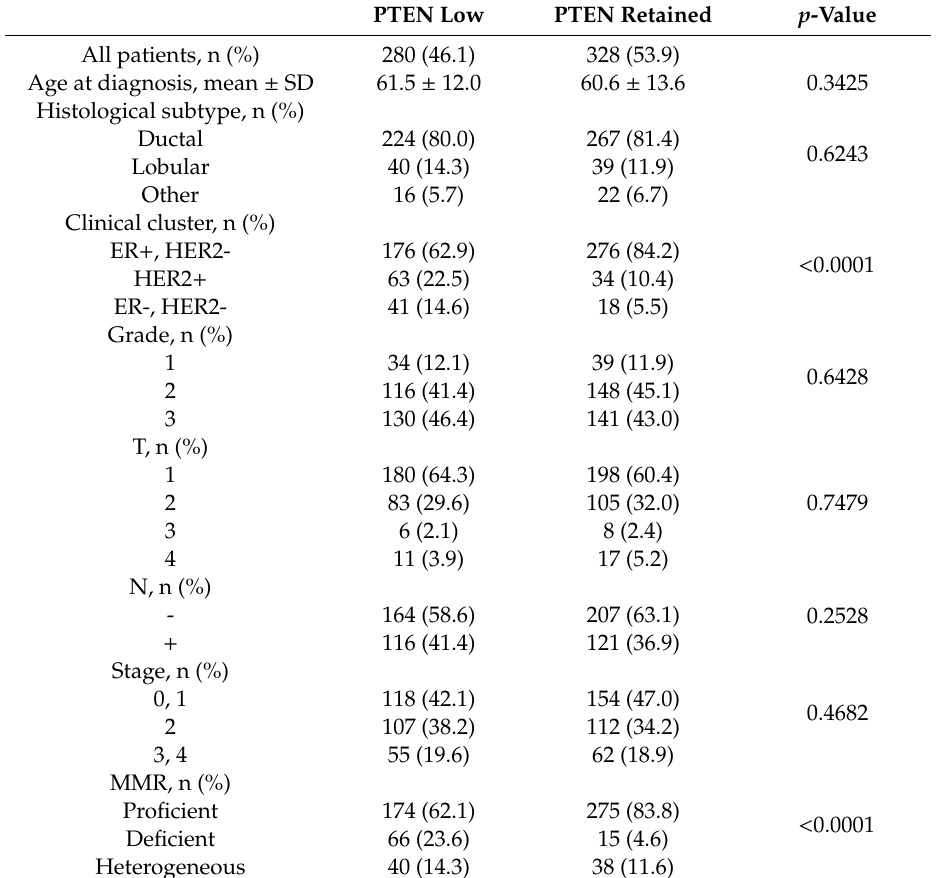
Table 1. Correlation between phosphatase and tensin (PTEN) and mismatch repair status across selected clinicopathologic features. SD, standard deviation; ER, estrogen receptor; MMR, mismatch repair. PTEN Low PTEN Retained p -Value All patients, n